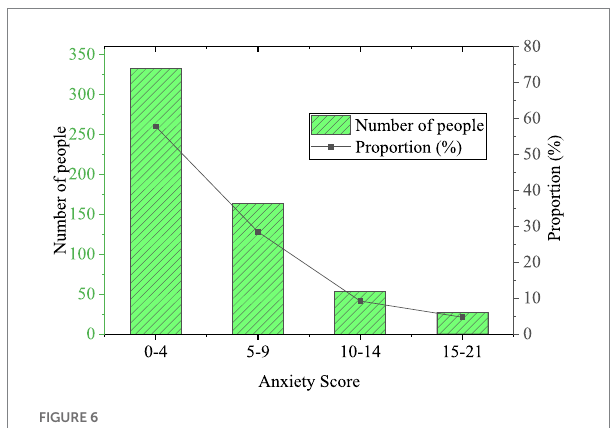
FIGURE 6 Anxiety scores of college students ( N = 577).